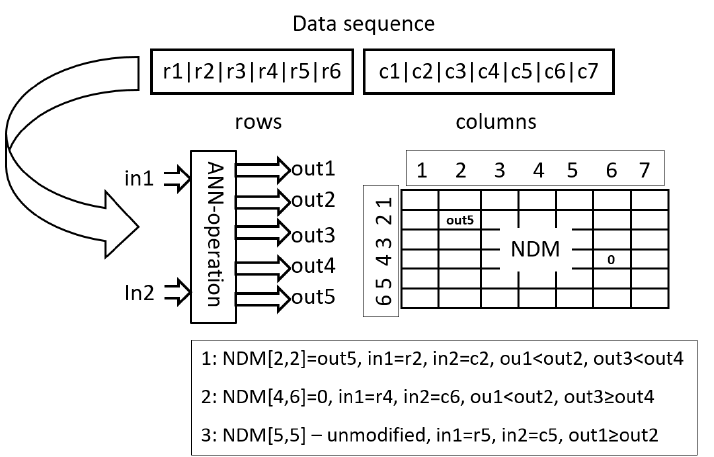
Figure 1. Applying ANN operations in Oper1 : ANN operation is run for each item in NDM, one after another, and it can change the value of each item. The figure shows applying the network to determine the value of three items: NDM[2,2], NDM[4,6] and NDM[5,5]. In the first case, the item is modified to the value out 5, which is the response of the network to the input r 2, c 2. r 2, c 2 are data items that correspond to the second row and column, that is, to the location of the modified item. The value out 5 is inserted into NDM because out 1 < out 2 and out 3 < out 4. In the second case, the item receives the value 0 because out 1 < out 2 and out 3 ≥ out 4. In addition, in the third case, the item is left unchanged because out 1 ≥ out